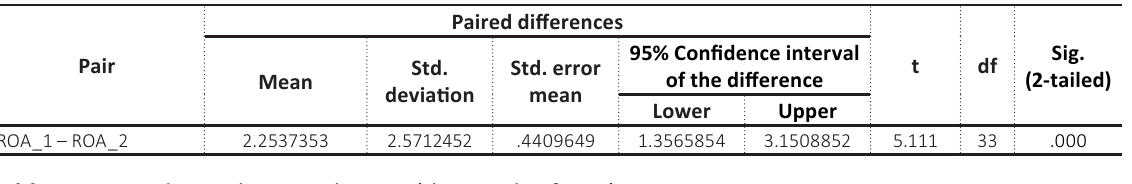
Table A9. Paired samples correlations (the result of H3a